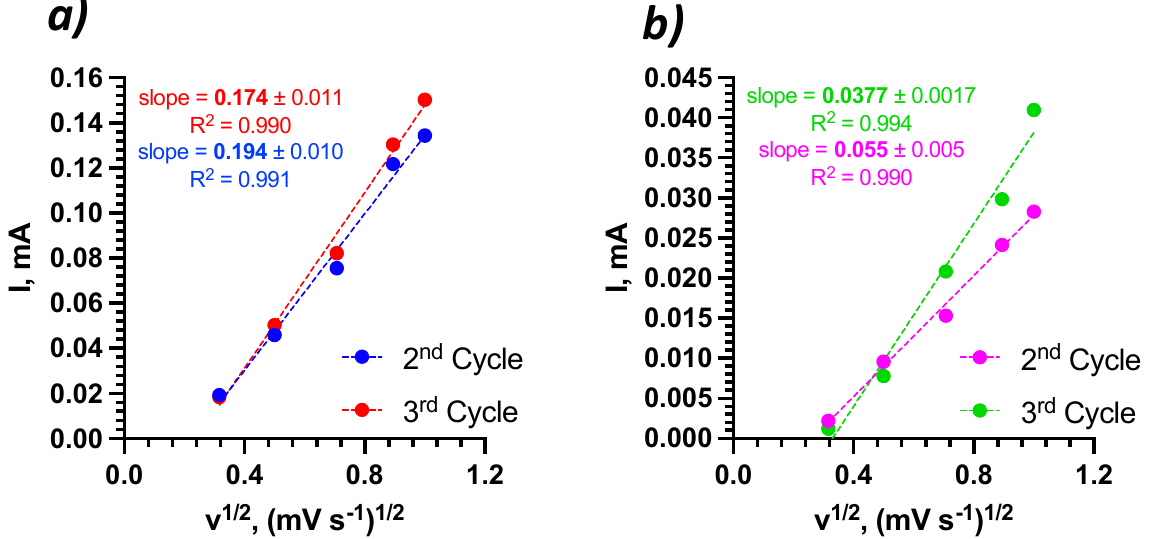
where D —diffusion coefficient (cm 2 s − 1 ); slope —the slope of the graph; n —number of elec- trons that participate in a reaction; F —Faraday constant (C mol − 1 ); A —surface area of the electrode (cm 2 ); C —electrolyte concentration (mol cm − 3 ); R —universal gas constant (J K − 1 mol − 1 ); T —temperature (K). Figure 8. The contribution of capacitive and diffusion-controlled processes of Bi 2 Se 3 thin-film in 1 M NaNO 3 : ( a ) 2nd cycle; ( b ) 3rd cycle. Na + diffusion coefficients during intercalation–deintercalation were determined from the slopes of Figure 9, using Equation (9).